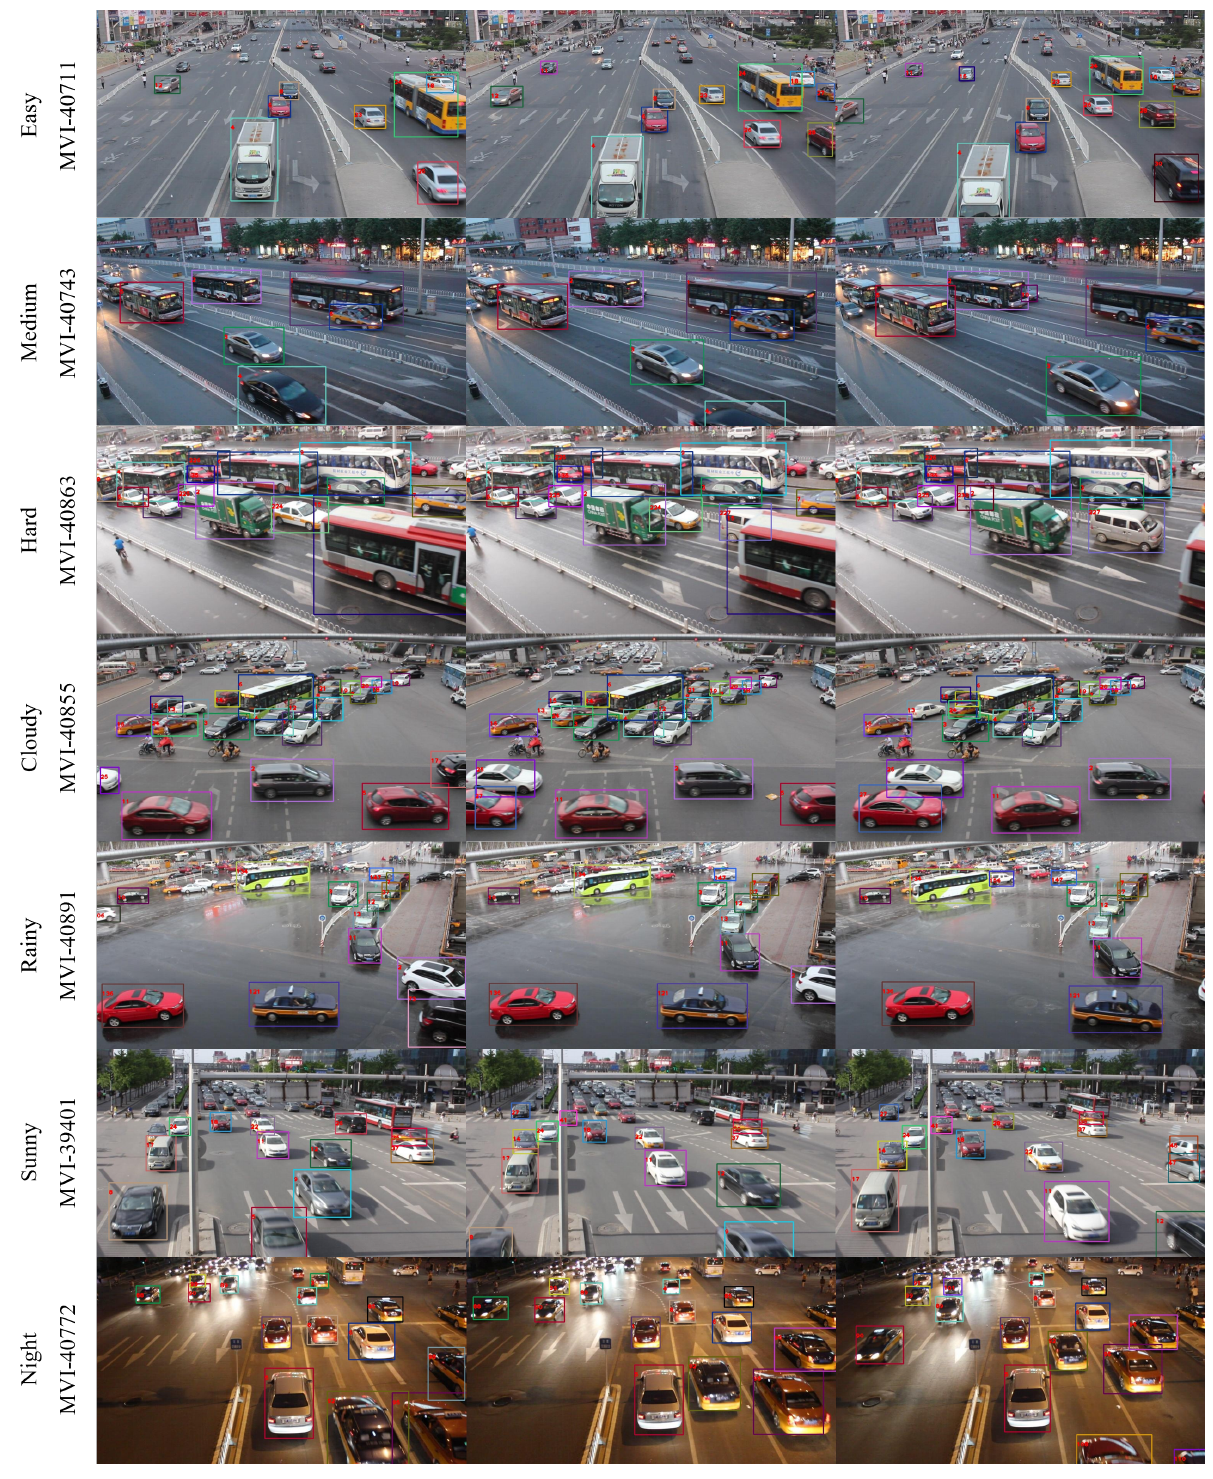
Figure 7. Qualitative results of our single-shot MOT system on the UA-DETRAC-test subsets. The frames are selected with a time interval of 20